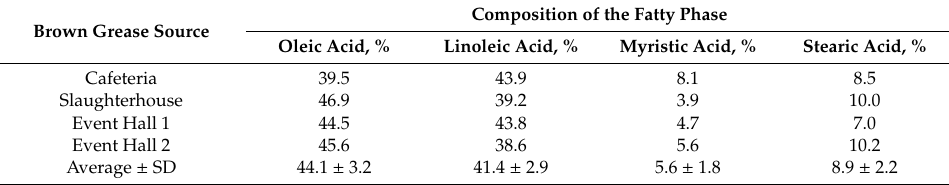
Table 1. Composition of brown grease fatty phase from various sources.